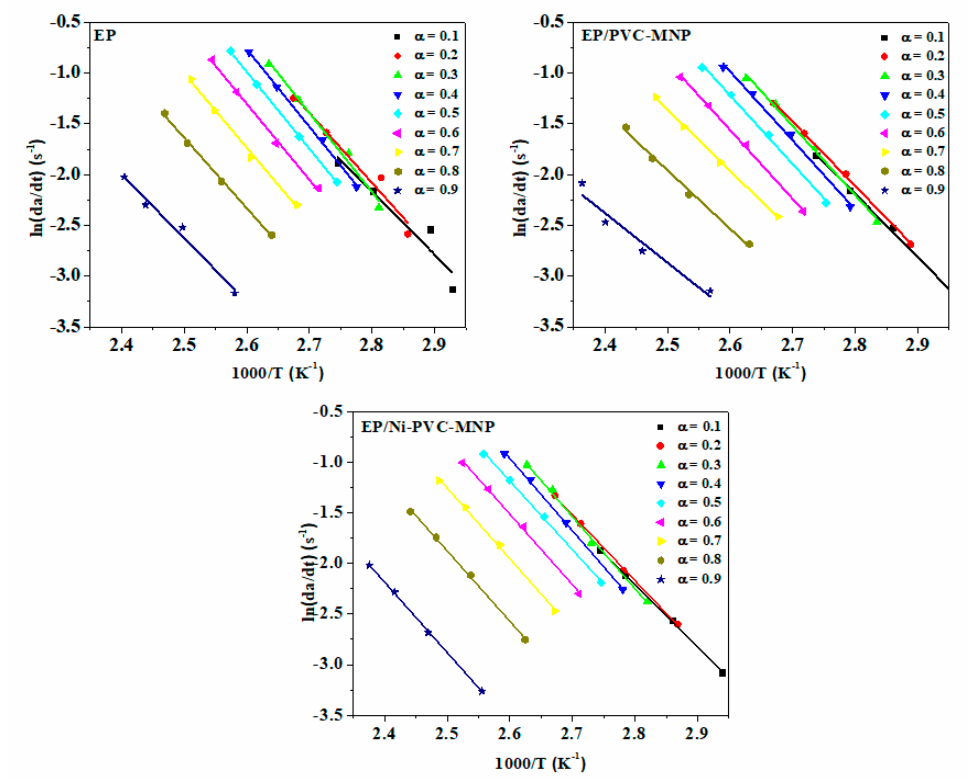
Figure A1. Fitting curves of ln(d α / dt) vs. 1 / T based on Friedman model at β = 5 ◦ C / min. (cid:16) (cid:17) β 2 Plotting ln vs. 1 / T α from Equation (6) gives a straight line; such that its slop gives i / T α , i